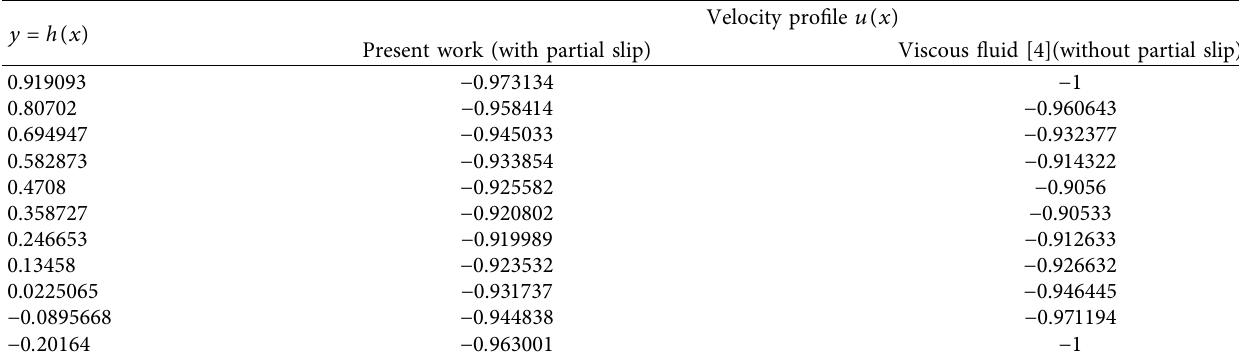
Table 1: A comparison with the existing literature.